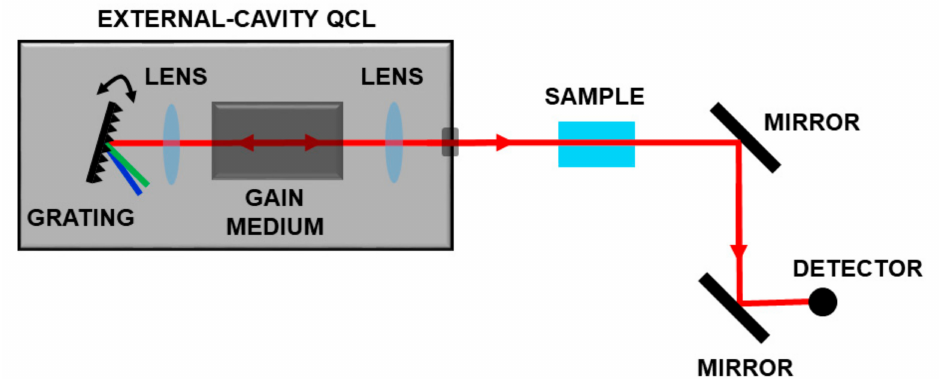
Figure 5. Spectroscopic set-up based on a broadband tunable QCL. By moving a grating, it is possible to select the operation wavelength on a very large frequency